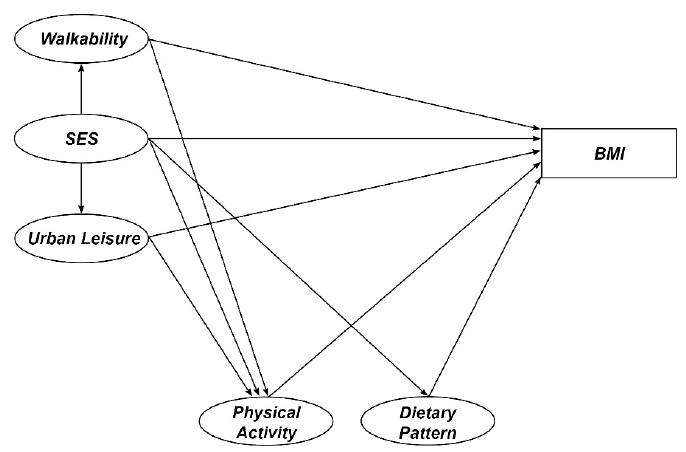
Figure 2. Research Figure 2. Research model.